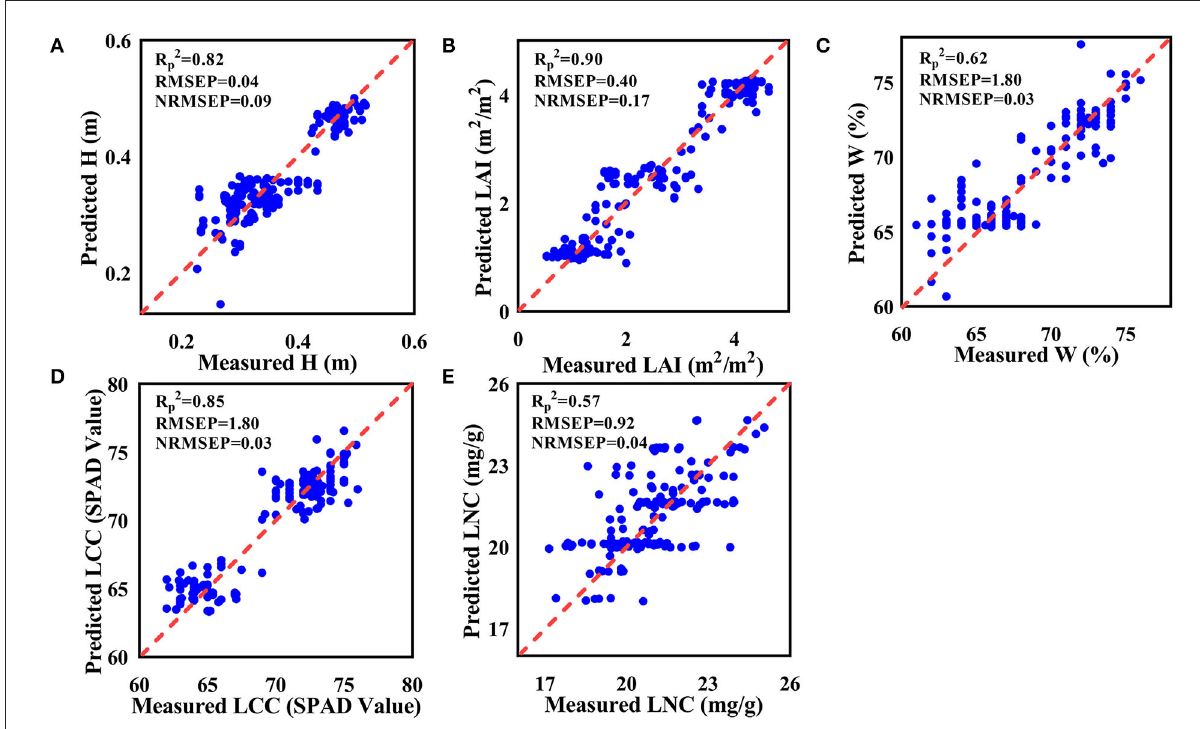
FIGURE9 Scatter plot of predicted and actual values of the model. (A) H; (B) LAI; (C) W; (D) LCC; (E)